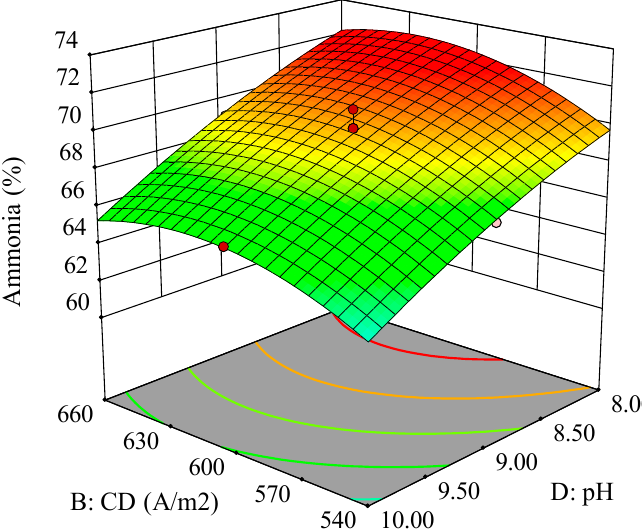
Figure 5. 3D surface plots for removal of ammonia on influences of current density and pH.